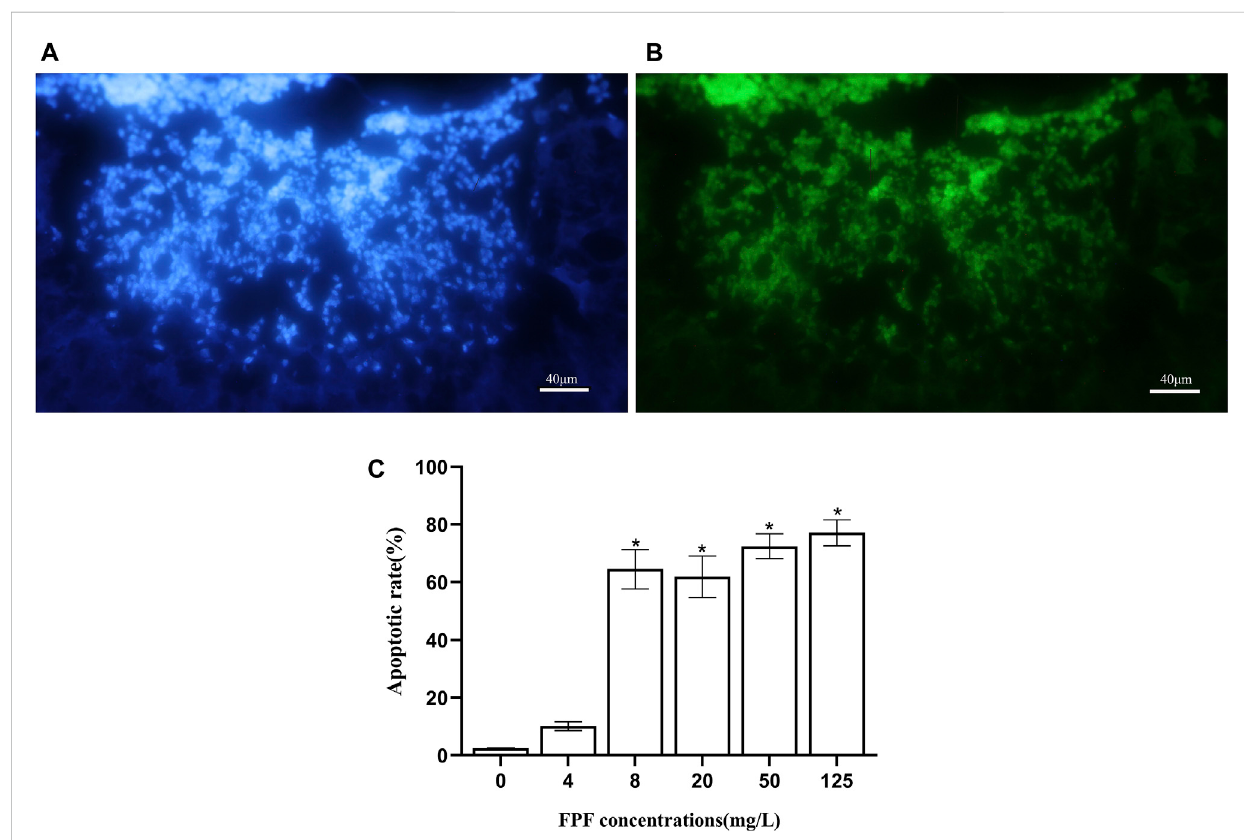
Flupyradifurone-induced apoptosis in neurons in the mushroom bodies of Apis mellifera. (A) Neurons stained by DAPI. (B) Apoptotic cells: TUNEL- positive cells. (C) Apoptotic rate of neurons in the mushroom bodies of A. mellifera induced by fl